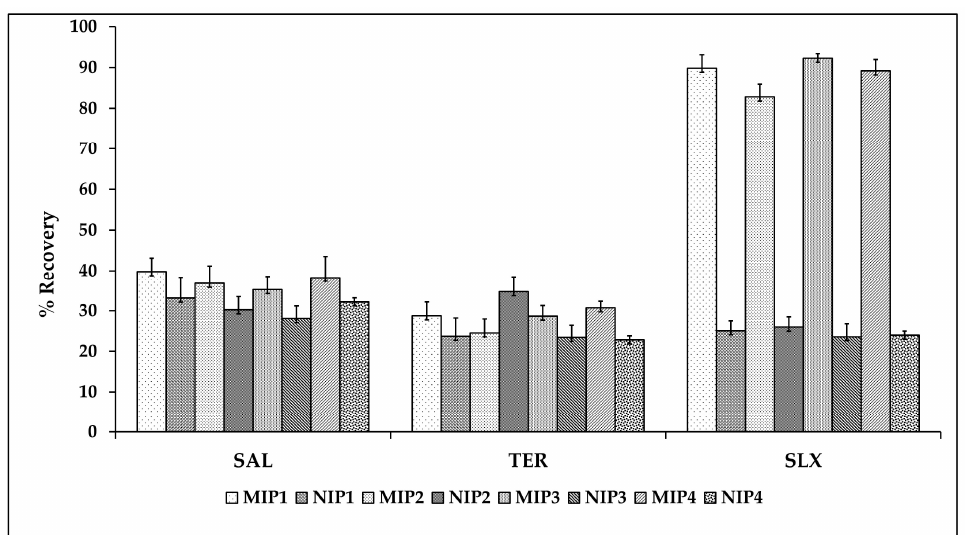
Figure 7. The selectivity of MISPE toward salbutamol (SAL), terbutaline (TER), and salmeterol xin- afoate (SLX). xinafoate